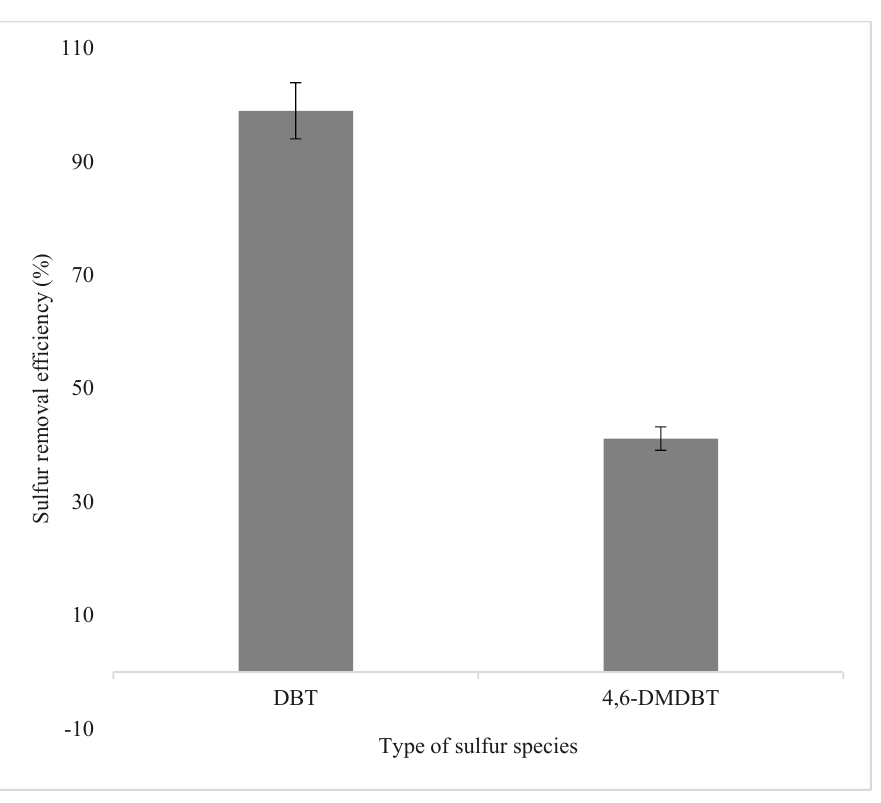
Figure 8. The effect of different types of sulfur species in the model oil on the sulfur removal efficiency (0.01 g Cu-Fe/TiO 2 , H 2 O 2 as an oxidant with a ratio to DBT of 1:2, 10 mL of 100 ppm concentration model oil, room temperature, EIL to model oil ratio of 1:5 and 600 rpm stirring speed).